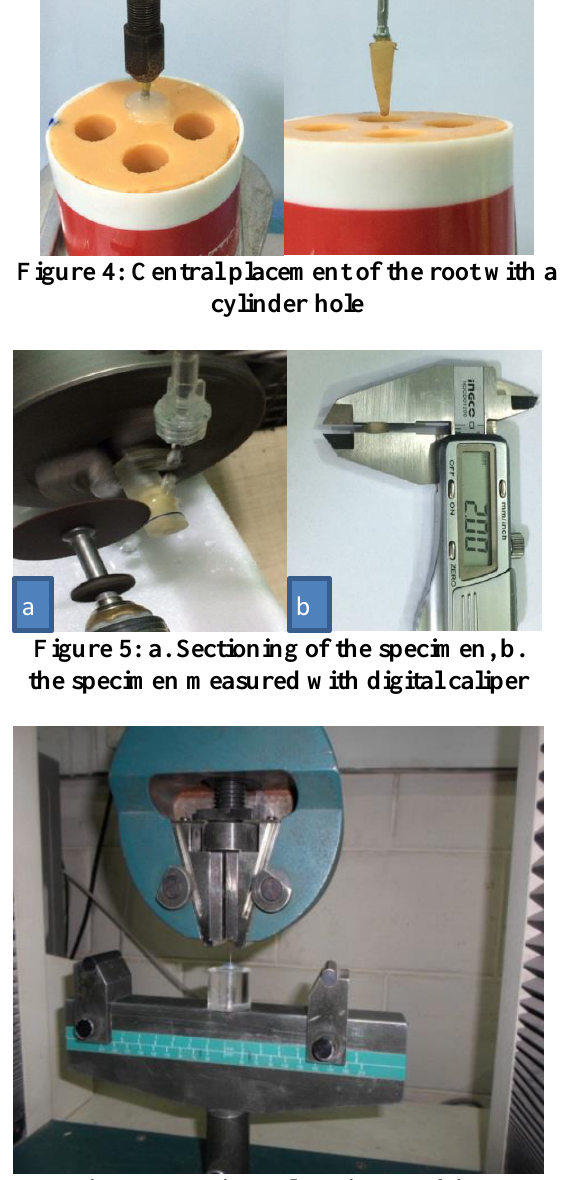
Figure 6: Universal testing